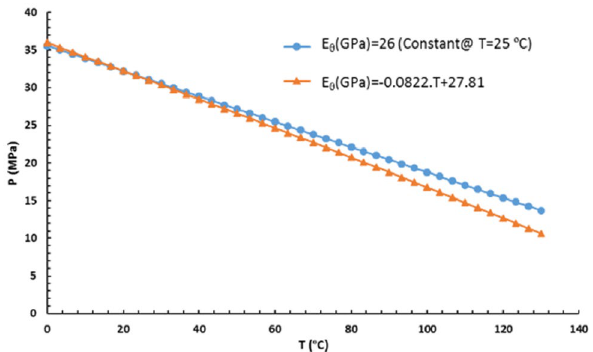
Fig. 10 Comparison of repaired pipe burst pressure constant and temperature dependent tensile elasticity